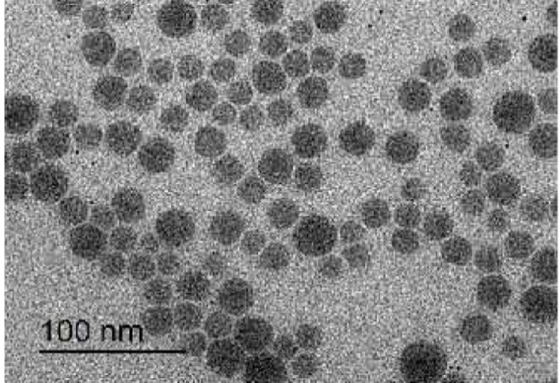
Figure 1. TEM photomicrograph of GTX loaded